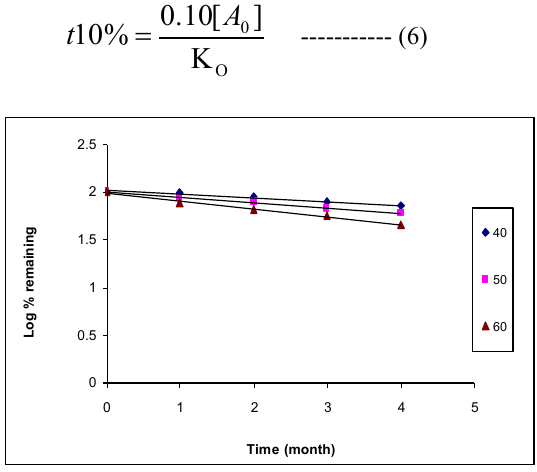
Figure (10): Degradation curve of centrifuged frusemide solution (formula A and D) at 40, 50, 60 0